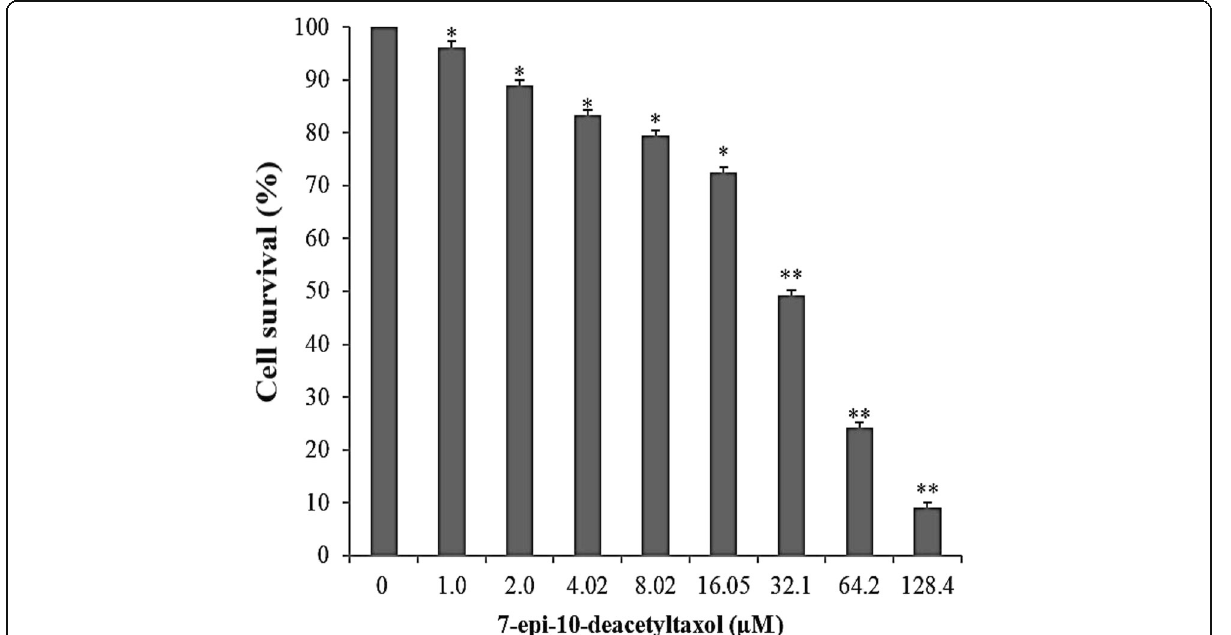
Fig. 6 Cytotoxicity of fungal EDT against human hepatoma HepG2 cells. Each IC 50 value represents means ± SD of 3 independent